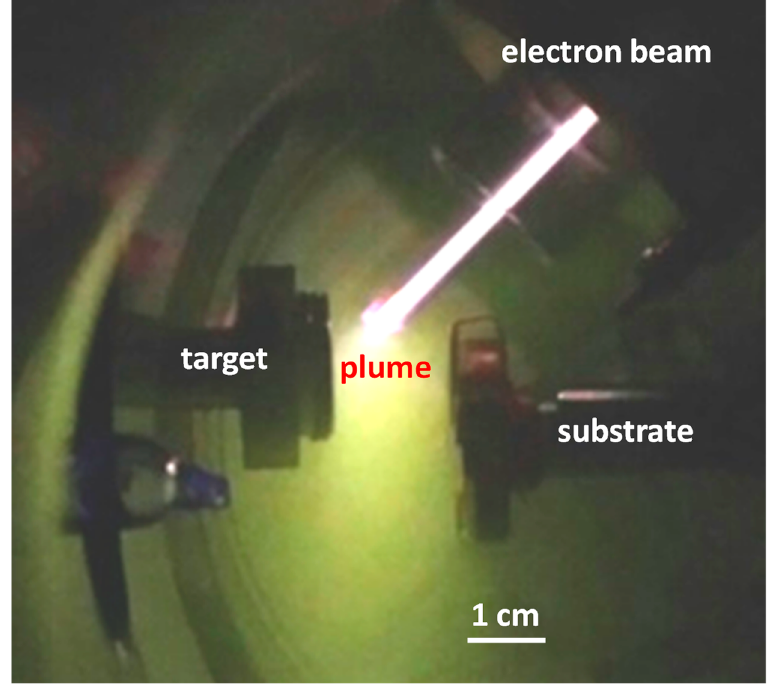
Figure 1. Photograph of the system during deposition of the In 2 O 3 film; gas used is oxygen.